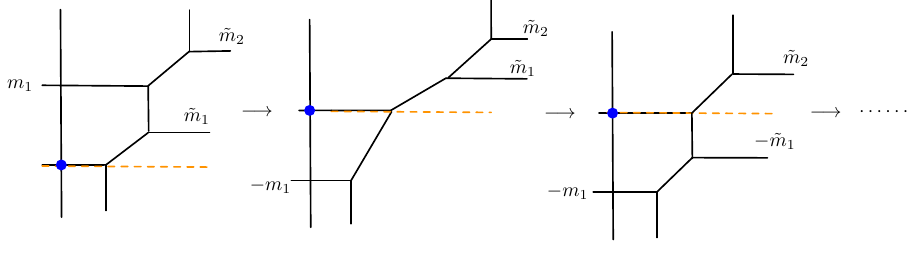
Figure 13 . Flipping D5-branes lead to a chain of equivalent 3d brane